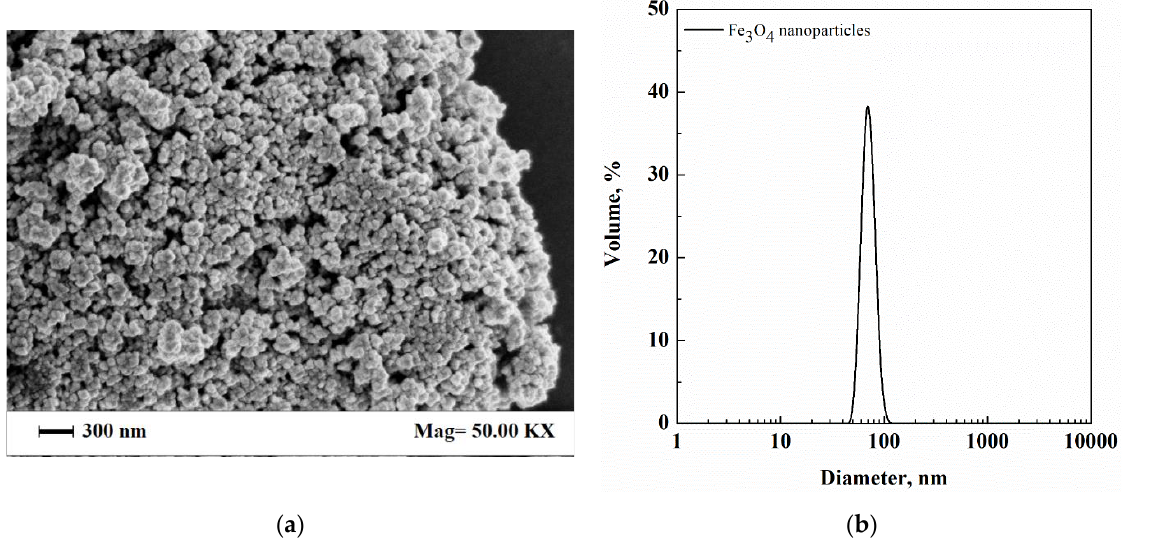
Figure 1. ( a ) SEM image of Fe 3 O 4 nanoparticles and ( b ) Fe 3 O 4 nanoparticles size distribution measured by DLS.